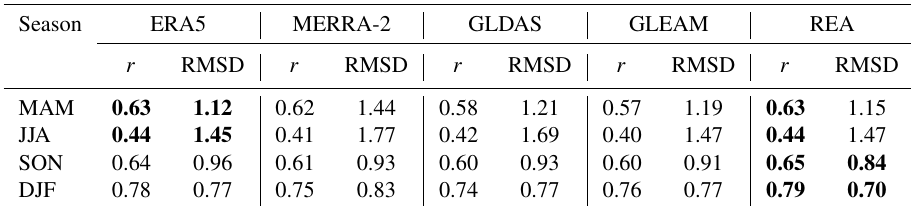
Table 4. The verification results including r and RMSD between daily ground-measured ET and daily ET from different products in different seasons. Values in bold indicate the highest quality.